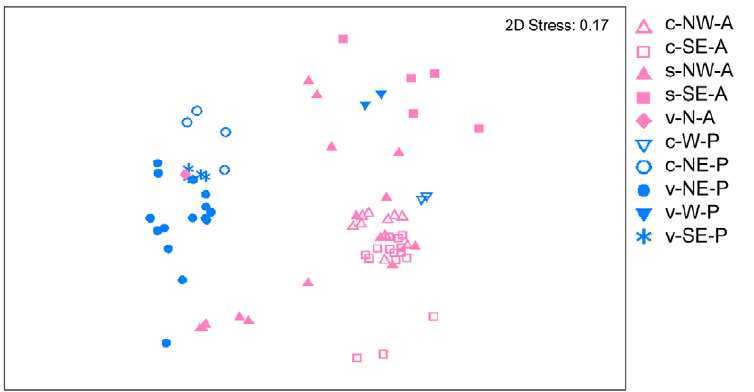
Figure 4. 2-dimensional MDS configuration plot for deep-sea seep, vent, and control samples from the Atlantic (pink colour code) and from the Pacific (blue color code). Division into ecosystem type is given by letters (vent (v), seep (s), and control (c)) and filled signs (for v and s) and open signs (for c). Detailed biogeographical information is specified by letter codes: Atlantic (A), Pacific (P), North (N), West (W), NW (Northwest), SE (Southeast).